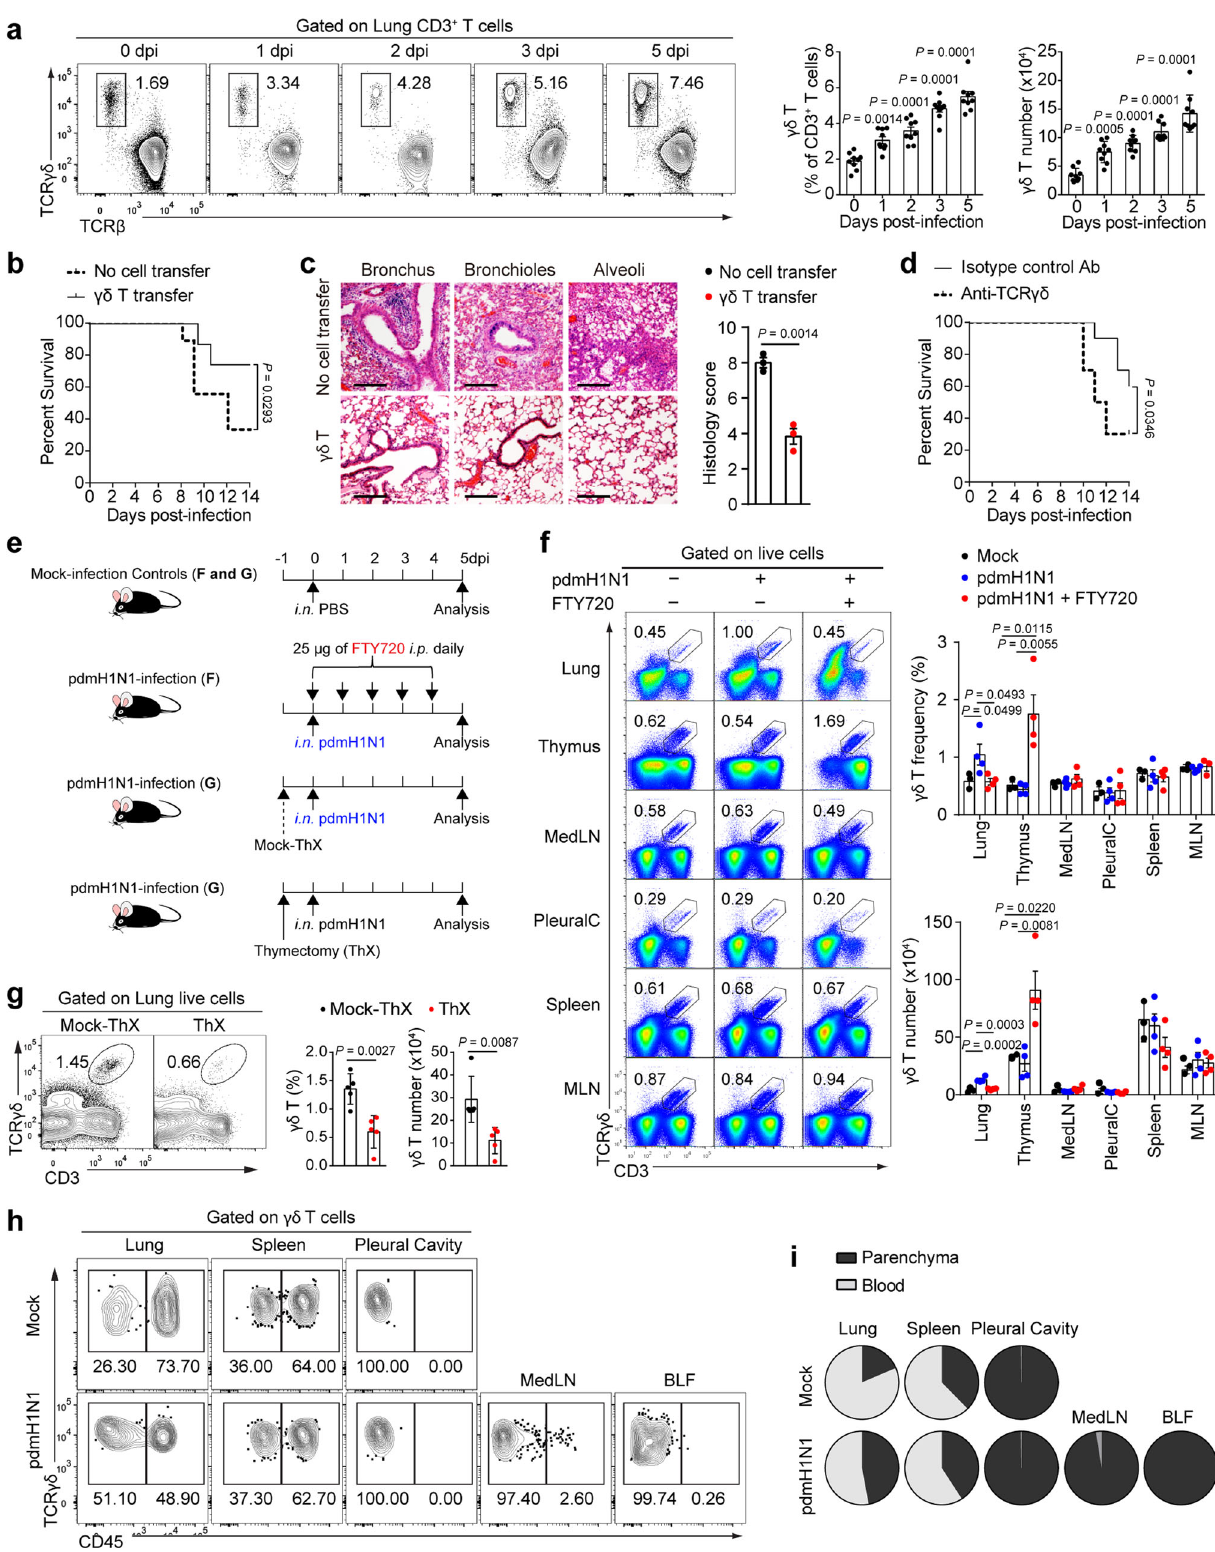
proceeding from the vasculature and CD45 − cells residing in the parenchyma of various organs. Following infection, the proportion of CD45 − γδ T cells in the parenchyma among total γδ T cells in the lung markedly increased. In contrast, the proportions of CD45 + and CD45 − γδ T cells remained largely unchanged in the spleen and pleural cavity, and only very small